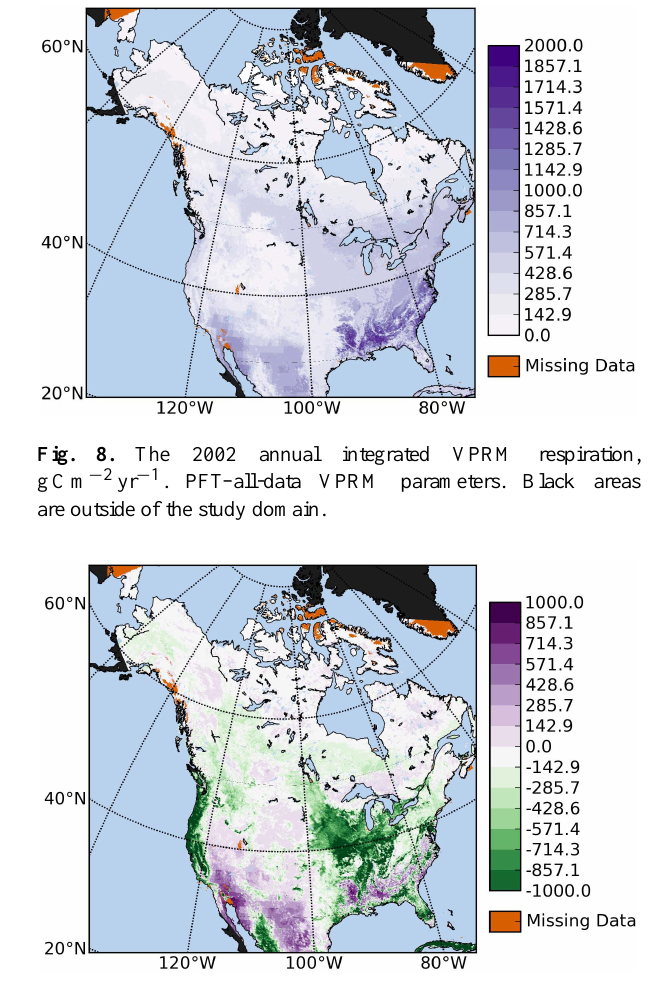
Fig. 9. The 2002 annual integrated VPRM NEE, gCm − 2 yr − 1 . PFT–all-data VPRM parameters. Black areas are outside of the study